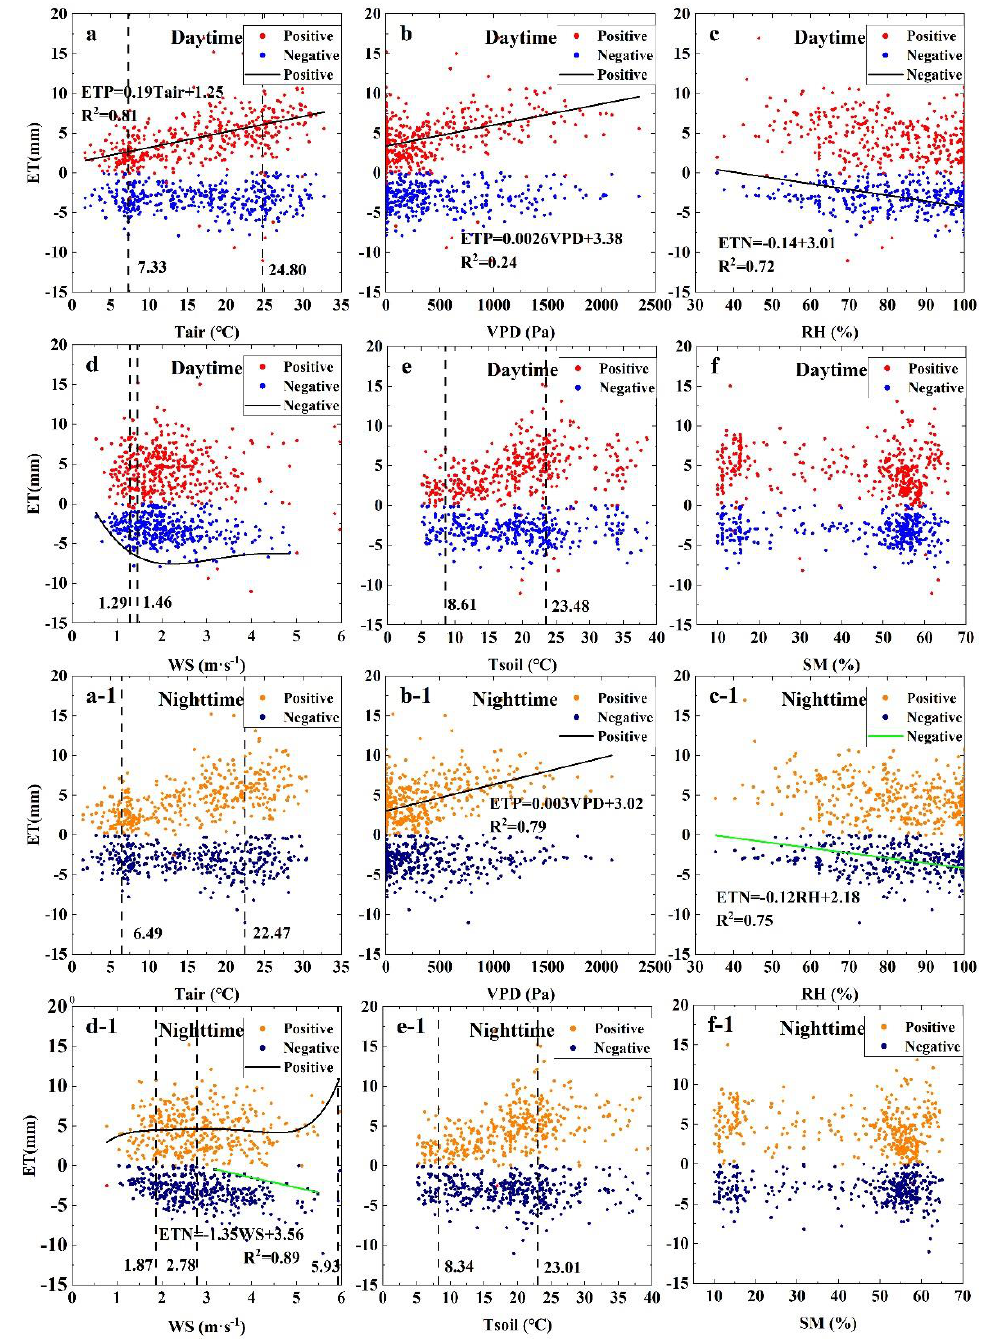
Figure 11. Relationships between ET and the environmental factors in the alternation of day and night. ( a – f ) Relationship between environmental factors and ET in daytime: ( a ) Tair represents air temperature, ( b ) VPD represents vapor pressure deficit, ( c ) RH represents relative humidity, ( d ) WS represents wind speed, ( e ) Tsoil represents soil temperature, ( f ) SM represents soil moisture. ( a-1 – f-1 ) Relationship between environmental factors and ET in nighttime; red scatter points represent positive values and blue represents negative values. ET represents evapotranspiration, ( a-1 ) Tair represents air temperature, ( b-1 ) VPD represents vapor pressure deficit, ( c-1 ) RH represents relative humidity, ( d-1 ) WS represents wind speed, ( e-1 ) Tsoil represents soil temperature, ( f-1 ) SM represents soil moisture.